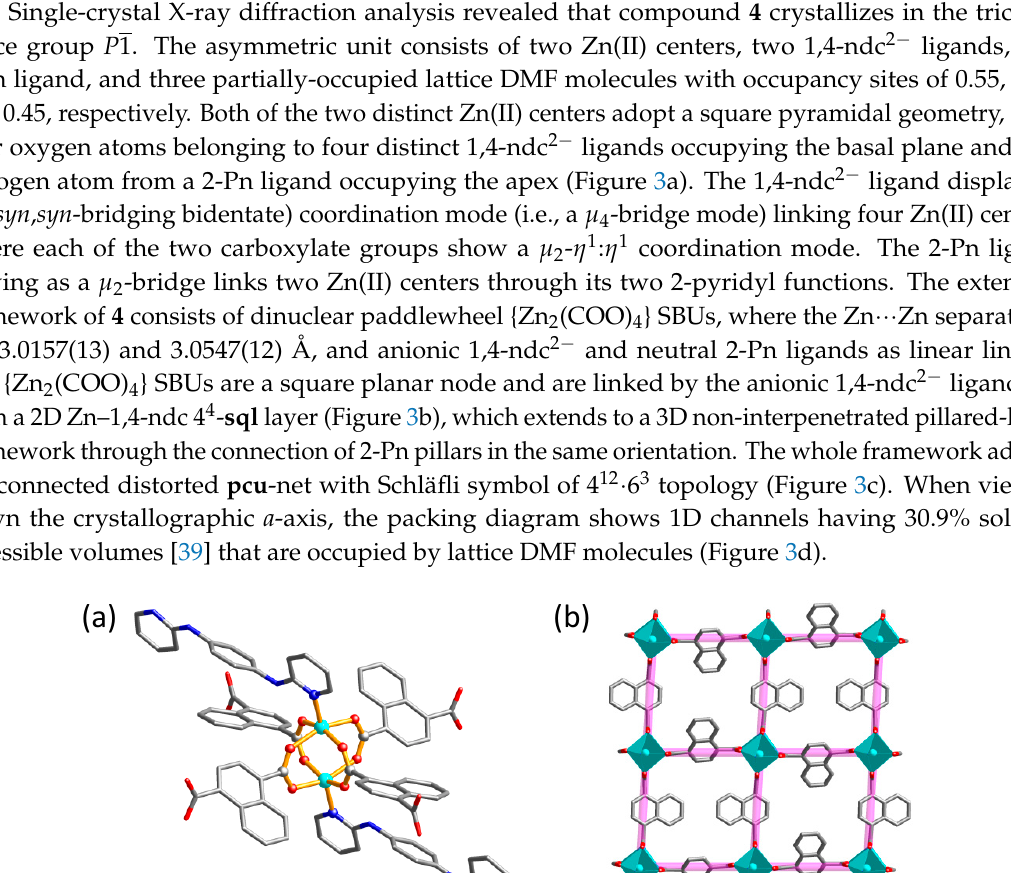
Figure 2. The molecular structure of 3 : ( a ) Coordination environment around Zn(II) center; ( b ) a single 2D Zn − thdc 4 4 ‐ sql layer; ( c ) schematic representation of the whole 6 ‐ connected non ‐ interpenetrated pillared ‐ layer framework of 4 8 ∙ 6 6 ∙ 8 ‐ topology; ( d ) packing diagram viewed down the crystallographic [101] direction, showing lattice DMF molecules inside the solvent accessible pores.